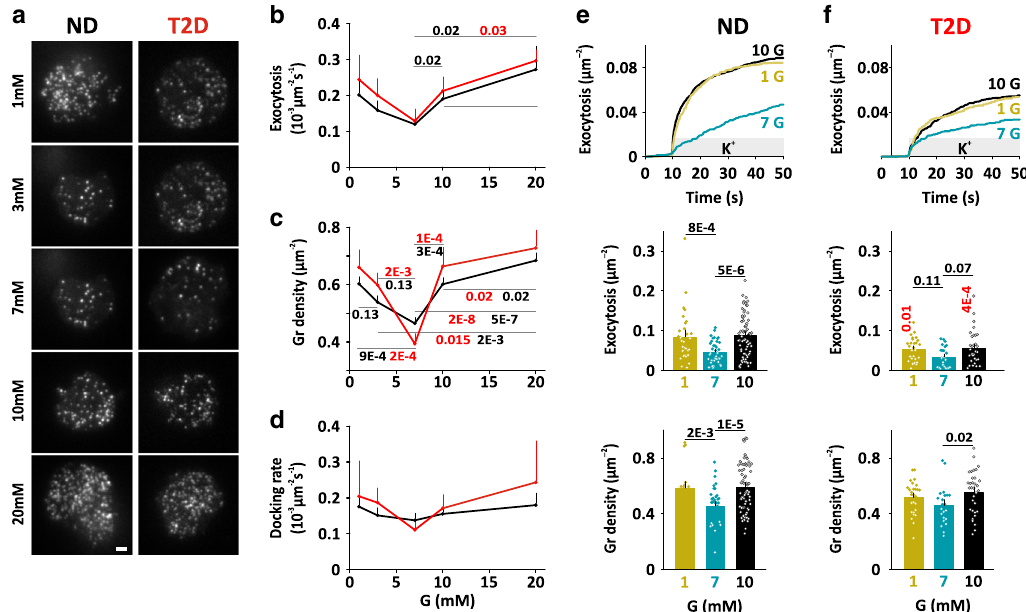
Fig. 3 Glucose dependence of α -cell exocytosis. a Examples TIRF images of dispersed ND (left) and T2D α -cells (right) expressing Pppg-NPY-EGFP, after equilibration in the indicated glucose concentrations. Scale bar 2 µ m. b Average exocytosis as function of ambient glucose concentration for dispersed ND (black) and T2D (red) α -cells as in a . For ND, n = 13 cells/3 donors at 1mM, 8 cells/2 donors at 3 mM, 13 cells/2 donors at 7 mM, 15 cells/3 donors at 10mM, and 10 cells/2 donors at 20mM). For T2D, n = 7 cells/2 donors at 1 mM), 9 cells/2 donors at 3 mM, 10 cells/2 donors at 7 mM, 10 cells/2 donors at 10mM, and 7 cells/2 donors at 20mM. Data are presented as mean values ± SEM. c Docked granules (average granule density) as function of ambient glucose concentration for ND (black, n = 32 cells/5 donors at 1 mM, 32 cells/5 donors at 3 mM, 32 cells/5 donors at 7 mM, 32 cells/5 donors at 10mM, and 32 cells/5 donors at 20mM) and for T2D cells (red, n = 11 cells/2 donors, 11 cells/2 donors at 3 mM, 17 cells/2 donors at 7 mM, 16 cells/3 donors at 10mM, and 11 cells/2 donors at 20mM). Data are presented as mean values ± SEM. In b , c p -values in black or red for comparisons as indicated by a line in ND group or T2D group respectively (two-tailed t -test). d Average rate of docking (granules becoming immobilized in the TIRF plane) as function of the ambient glucose concentration in the same cells as in b . Data are presented as mean values ± SEM. e Cumulative time course (upper), total exocytosis (middle), and initial density of docked granules (lower) during K + -stimulated exocytosis in dispersed ND α -cells bathed in 1 mM (30 cells/6 donors, yellow), 7mM (38 cells/6 donors, blue) or 10mM glucose (71 cells/14 donors, black). Stimulation was from 10 to 50s. Data are presented as mean values ± SEM. f As in e , but for dispersed T2D α -cells. n = 27 cells/5 donors at 1mM, 24 cells/3 donors in 7 mM, and 33 cells/6 donors in 10mM glucose. In e , f , p -values in black for comparisons as indicated by a line, or in red comparing ND and T2D for the same condition (oneway ANOVA, Fisher posthoc